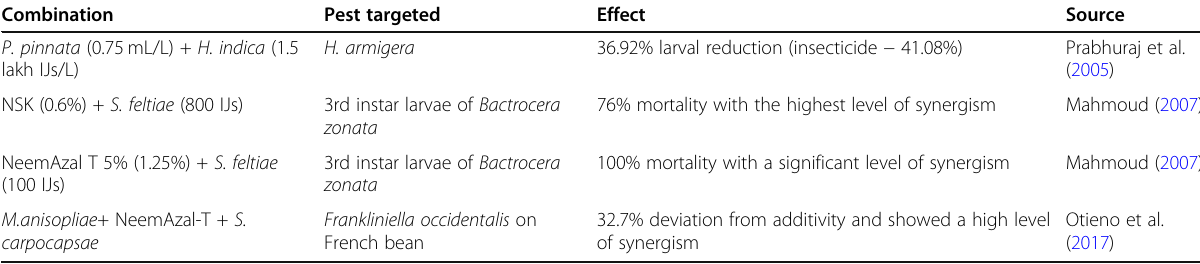
Table 4 Some botanicals and entomopathogenic nematode combinations